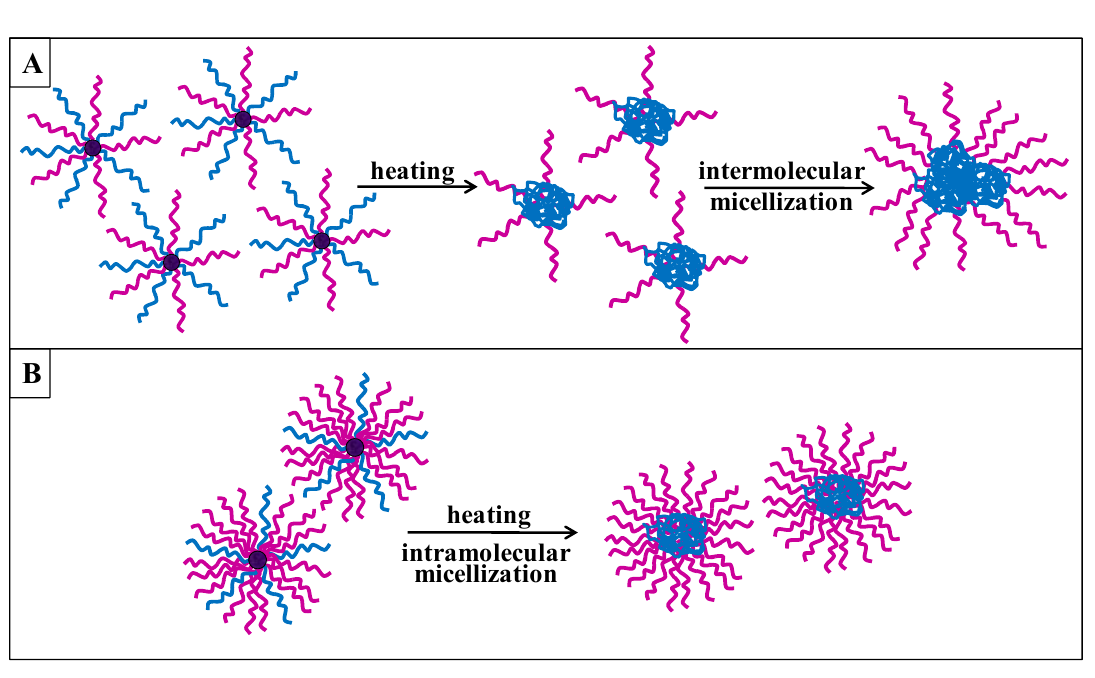
PEG star copolymer. 13 m